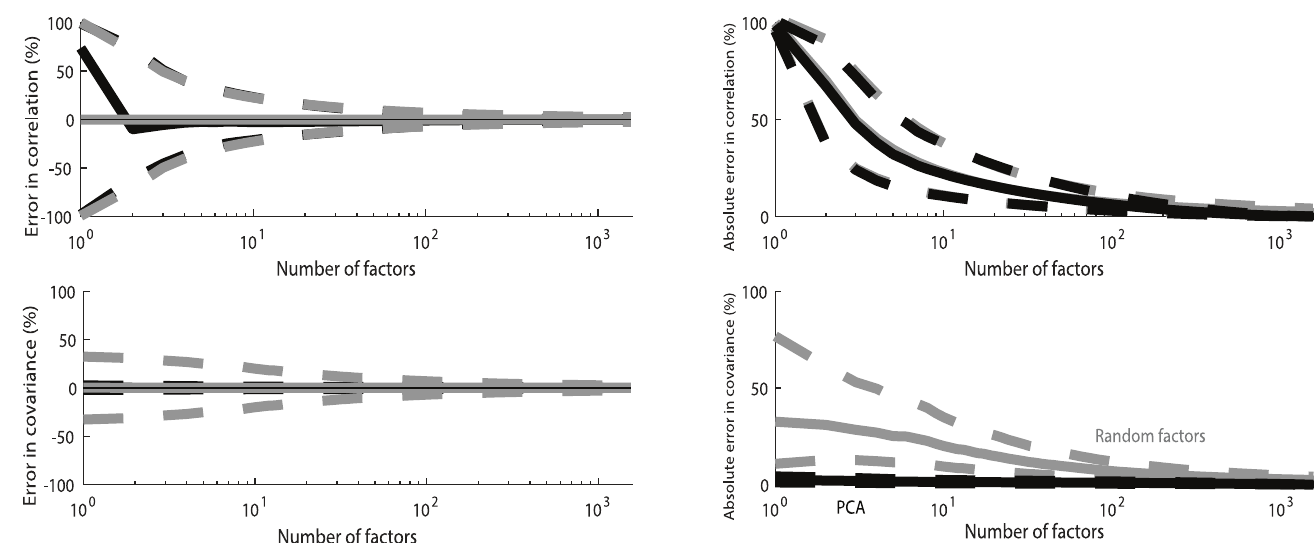
Fig 6. Analysis of the reduced data set in which the influence of the market is removed. Error and absolute error in correlation coefficient and in covariance estimates in an random factor model (gray curves) and in PCA (black curves). Solid lines are median estimates, dashed lines 25th and 75th percentiles.